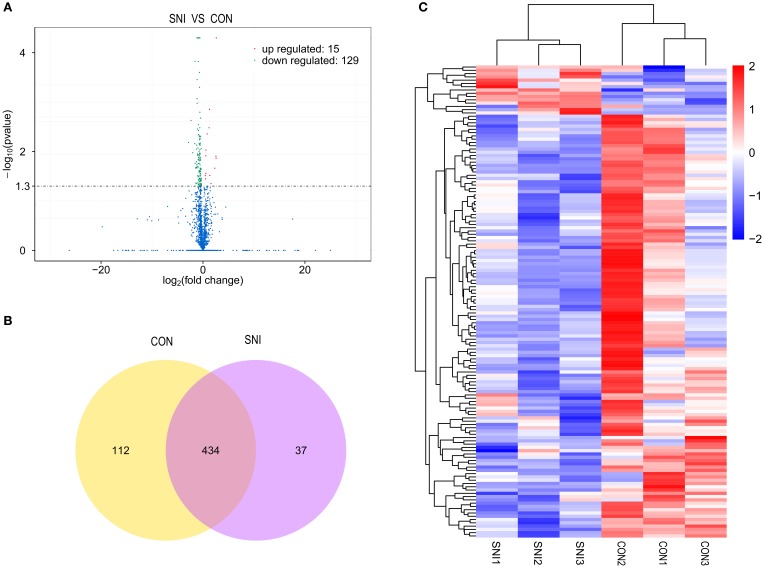
The expression profiling changes of lncRNAs in spinal cord of SNI rats Vocalno Plot indicate up and down regulated lncRNAs of rats in group SNI compared with group CON (A); Venn diagram showing the number of overlap lncRNAs in group SNI compared with group CON (B); Heat map of lncRNAs showing hierarchical clustering of changed lncRNAs of rats in group SNI compared with group CON. In clustering analysis, up- and down-regulated genes are colored in red and blue, respectively (C).